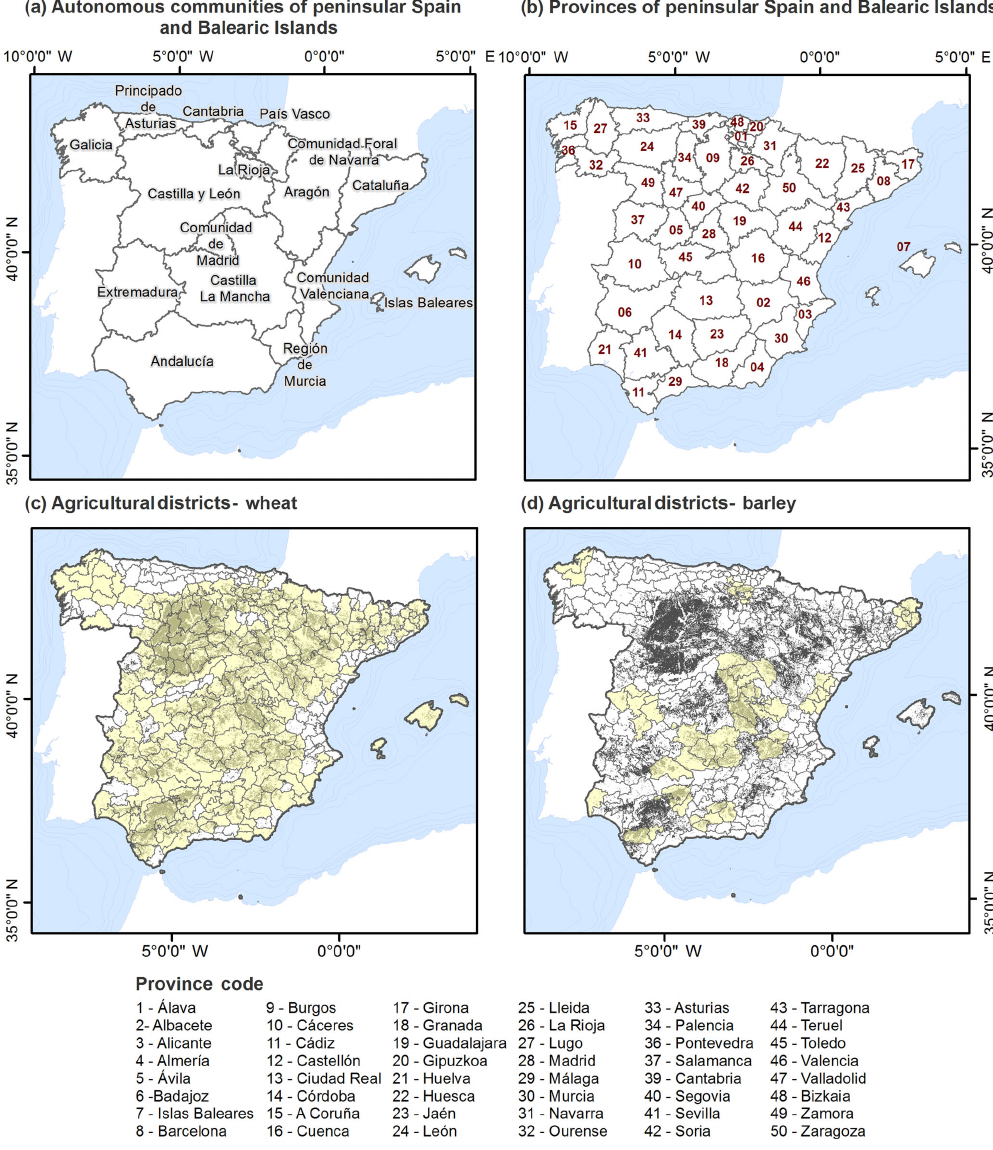
Figure 1. Location of Spanish autonomous communities (a) and provinces (b) and the distribution of agricultural districts with data available (yellow) for wheat (c) and barley (d) yields for the period 1993–2015. Areas where rainfed cereal crops are cultivated (Corine Land Cover 2006) are shown in